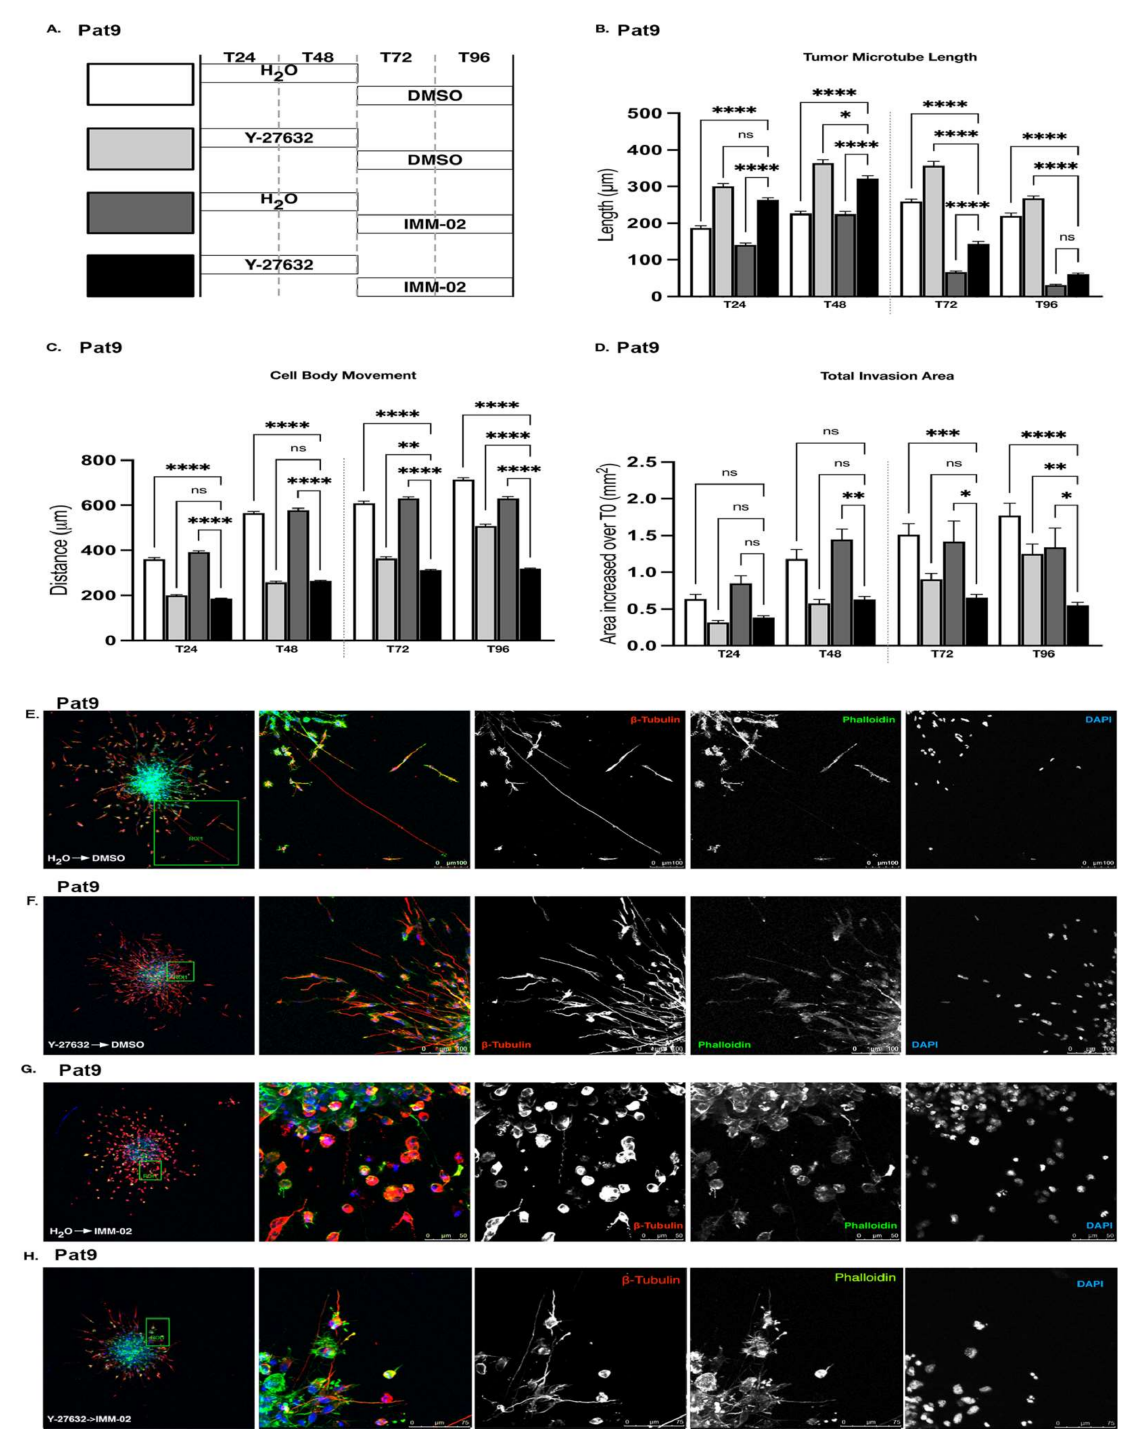
Figure 4. Altered the sequencing of combined ROCKi/mDia targeting does not modulate GBM invasion. ( A ) Schematic of drug exposures in drug-switch 3D invasion assays (Y-27632 = 90 µ